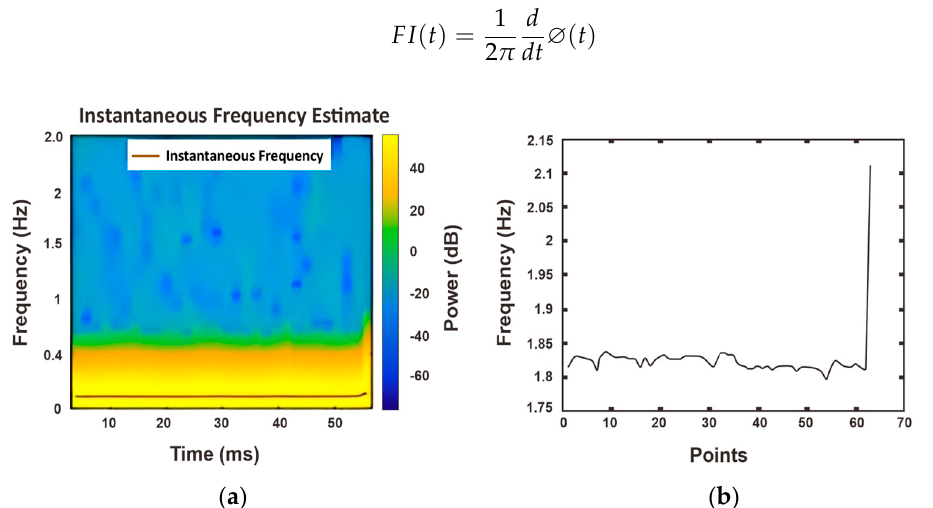
Figure 7. ( a ) The instantaneous frequency function estimates the time − dependent frequency of a signal as the first moment of the power spectrogram. ( b ) The instantaneous frequency from the spectrogram using short–time Fourier transforms over time windows. In this example, the function uses 63 time windows.